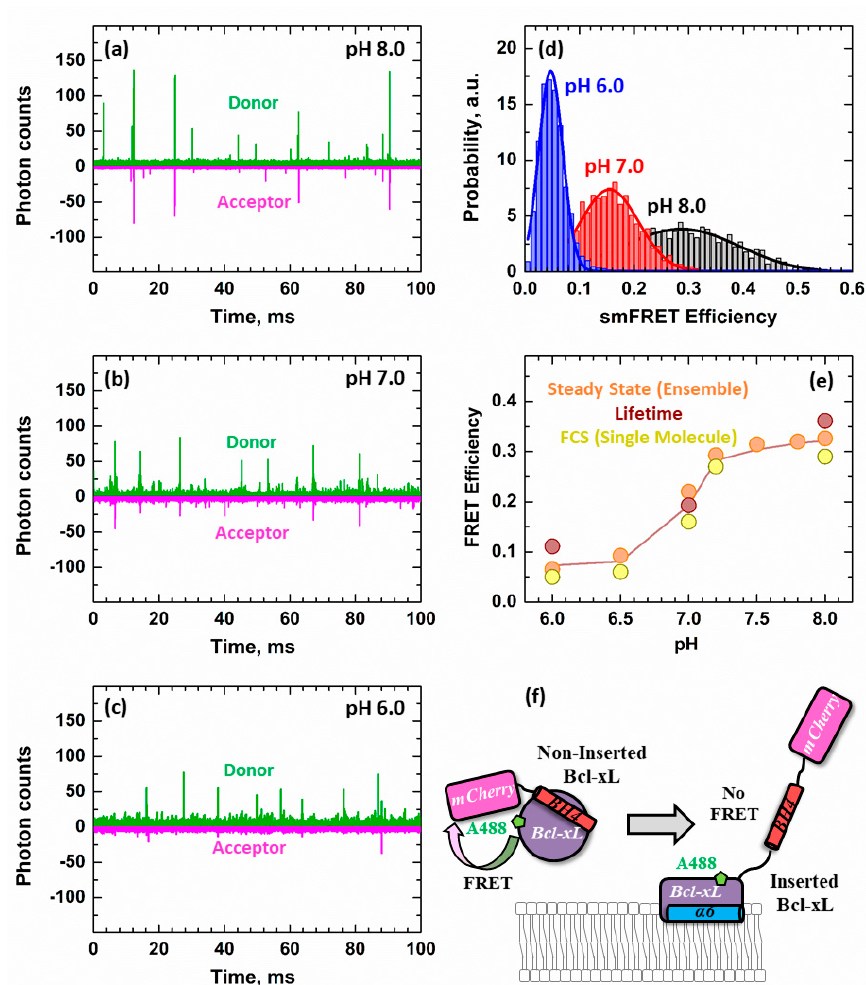
Figure 6. Single-molecule FRET measurements of Bcl-xL refolding. The release of the N-terminal BH4 ( α 1) helix was inspected at the single-molecule level by fluorescence correlation spectroscopy (FCS) in the presence of 1TOCL:2POPC LUV. Measurements were performed using the same Bcl-xL construct used in Figure 5 between an N-terminally conjugated mCherry fluorescent protein (donor) and acceptor Alexa-Fluor-488 fluorophore introduced at D189C (Figure 2). ( a – c ) Representative snapshots of FCS measurements showed individual fluorescence signals detected for each A488 donor (green) or mCherry acceptor (magenta) fluorophore detected. The presence of a spike appearing simultaneously in both acceptor and donor channels indicated positive FRET events between both fluorophores. The number of FRET events decreased proportionally with the pH of the sample. ( d ) The single-molecule FRET e ffi ciency (smFRET) in the sample was calculated using Equation (4) from the number of FRET events detected and fitted to a Gaussian distribution. The loss of FRET was characterized by a progressive shift of the distributions to lower FRET e ffi ciencies as a function of pH. This suggested the presence of multiple stable intermediate conformations during the refolding / membrane insertion of Bcl-xL, each with characteristic FRET distances between the BH4 helix and the rest of Bcl-xL. ( e ) The FRET e ffi ciencies determined by steady-state (Figure 5a), lifetime (Figure 5b), and FCS (Figure 6d) were plotted against experimental pH. ( f ) Schematic of the experimental set-up, indicating the presence of FRET when the acceptor mCherry was close to the donor A488 and the lack of FRET in the refolded / inserted form of Bcl-xL due to the increase in distance between the donor-acceptor pair. The smFRET data indicated that the release of the BH4 helix was not a two-state transition and involved several Bcl-xL intermediates of various compactness.